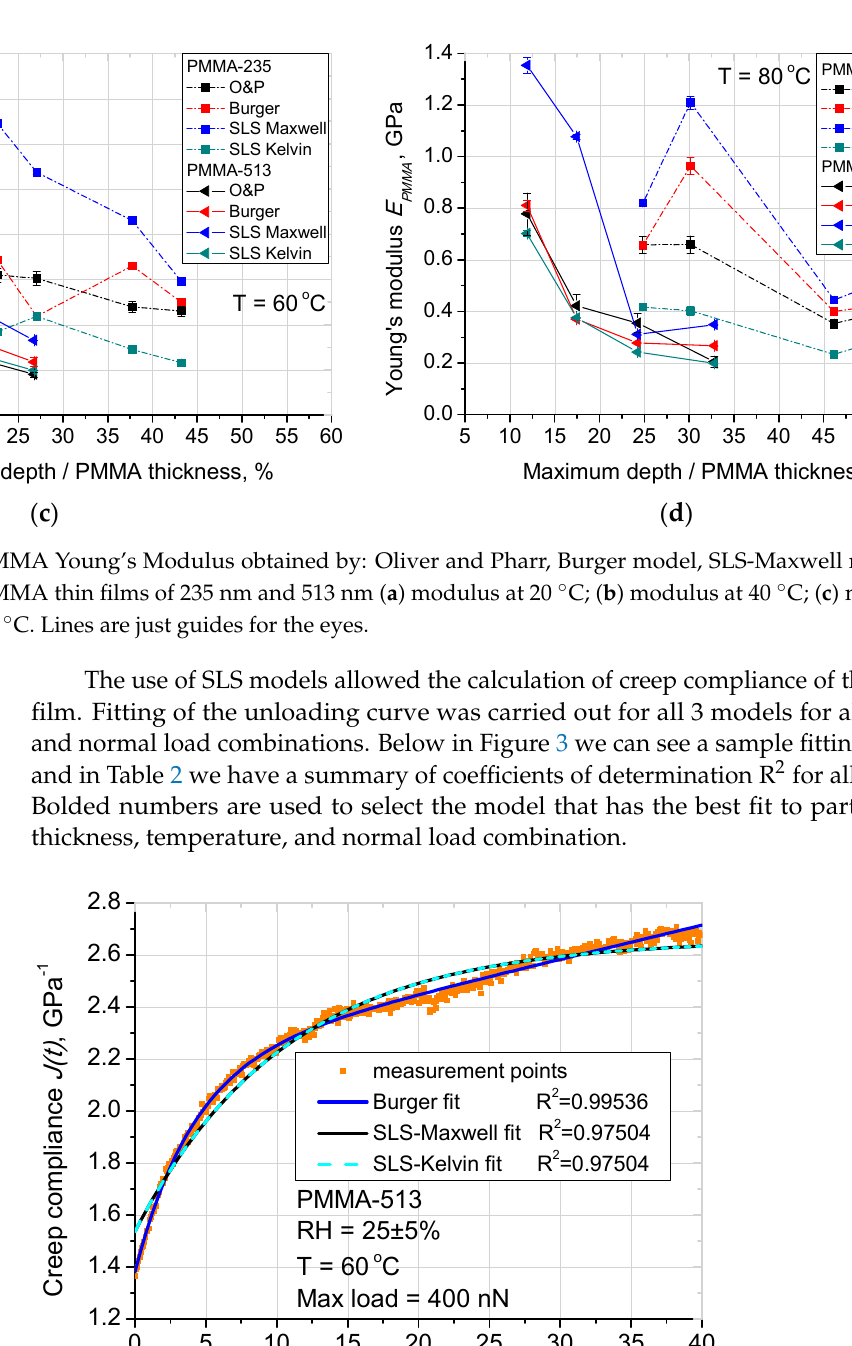
Figure 3. Analysis of SLS models: Burger model, SLS-Maxwell model and SLS-Kelvin model, creep compliance for PMMA-513, temperature 60 °C, maximum load 400 nN—comparison used creep models.